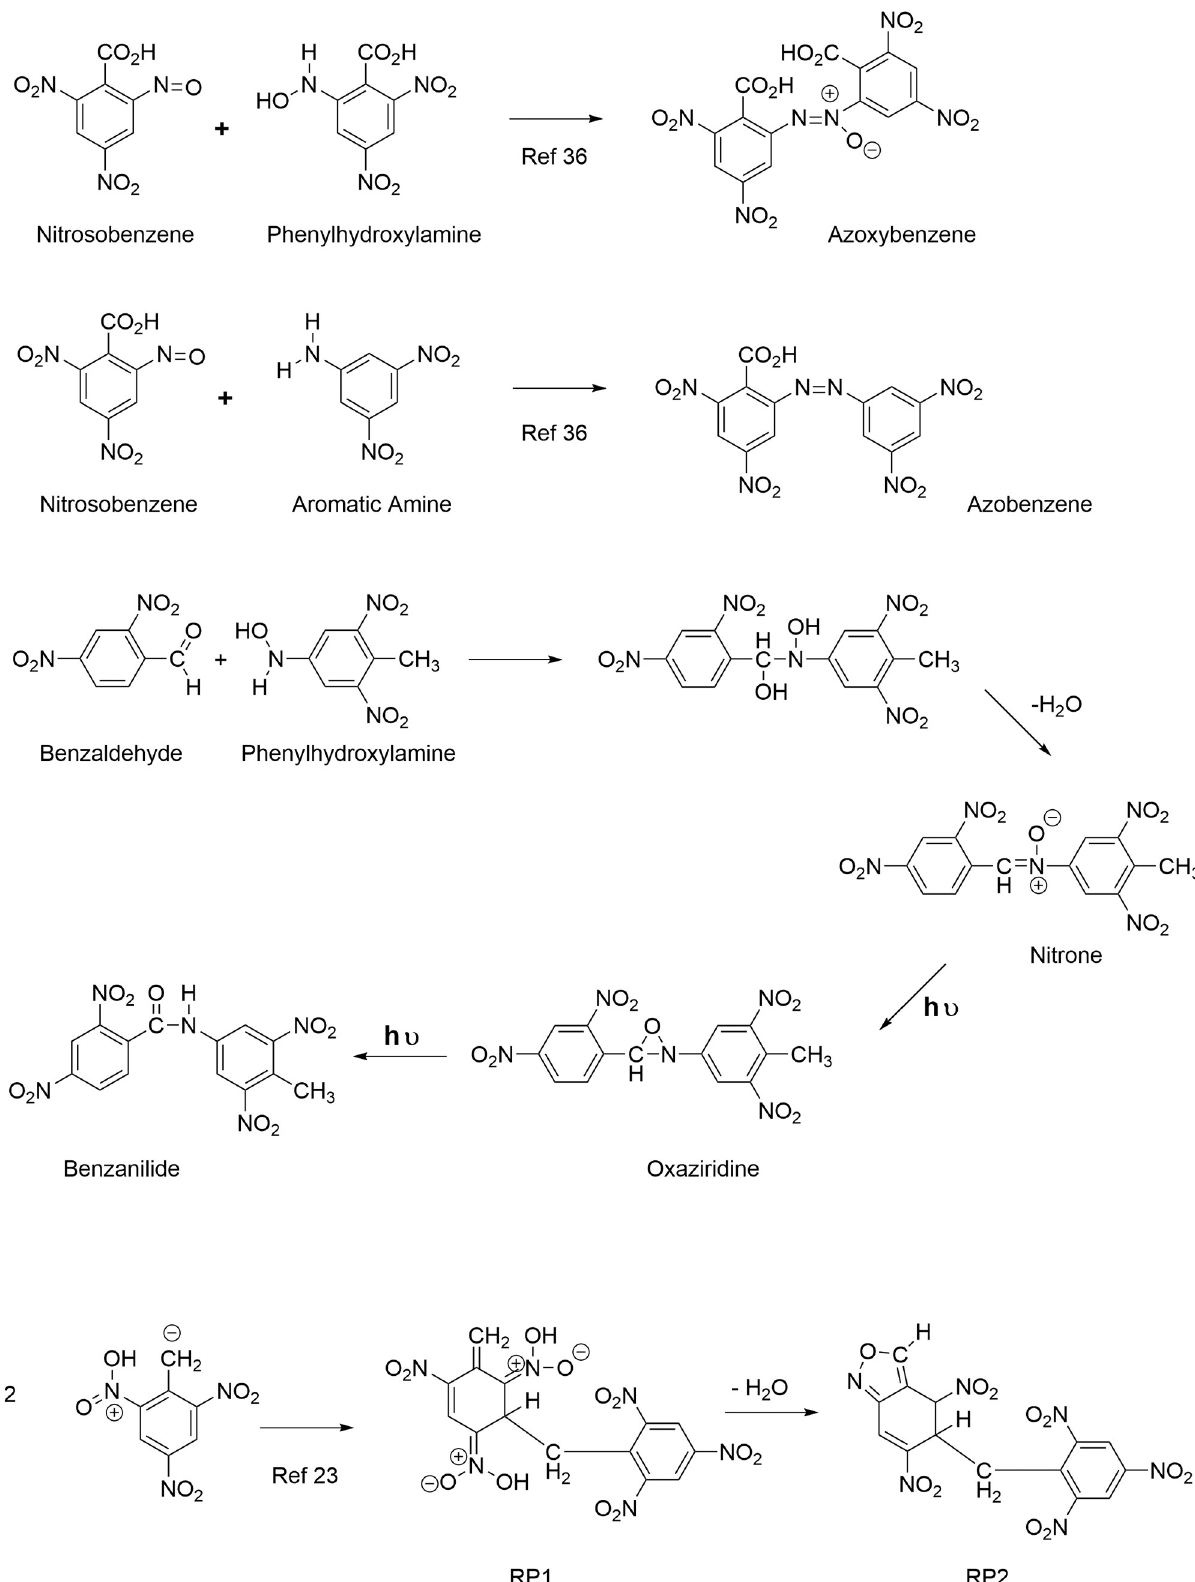
Fig 3. Photochemical transformation reactions of TNT. https://doi.org/10.1371/journal.pone.0224112.g003 PLOS ONE | https://doi.org/10.1371/journal.pone.0224112 October 22,